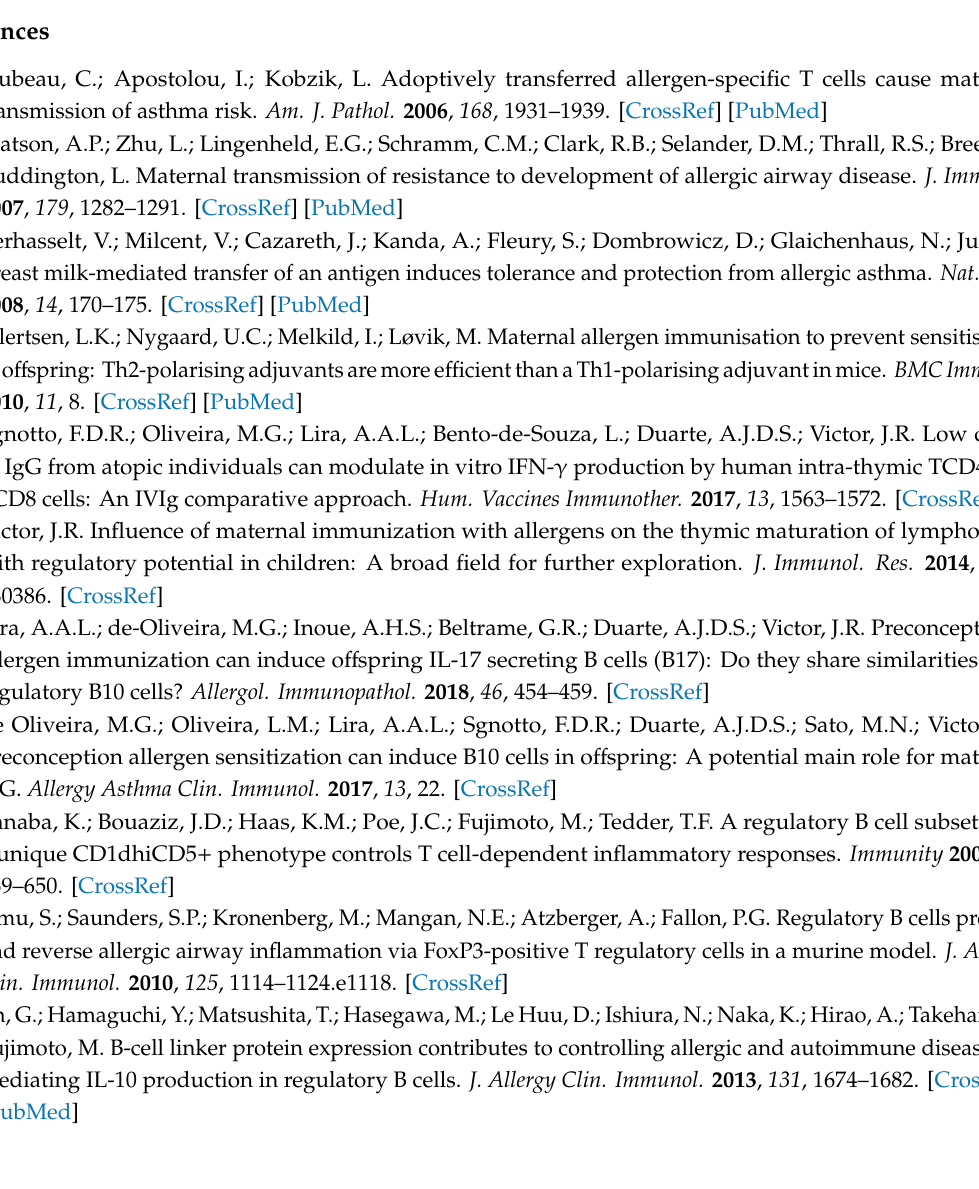
Figure S1. Schematic representation of the maternal immunization, o ff spring evaluation, o ff spring immunization, and murine lung inflammation protocols; Figure S2. Schematic representation of the passive in vivo transfer of purified IgG protocol; Figure S3. Schematic representation of the passive in vivo transfer of thymocytes protocols; Figure S4. Gating strategy to identify B cell precursors and evaluate CD1d expression in o ff spring bone marrow and thymic samples; Figure S5. Gating strategy to identify 3-d.o. o ff spring thymus B10 cells; Figure S6. Gating strategy to identify o ff spring thymus IL-10-producing B cells; Figure S7. Gating strategy to identify 20-d.o. o ff spring thymus B10 cells; Figure S8. Murine and human IgG